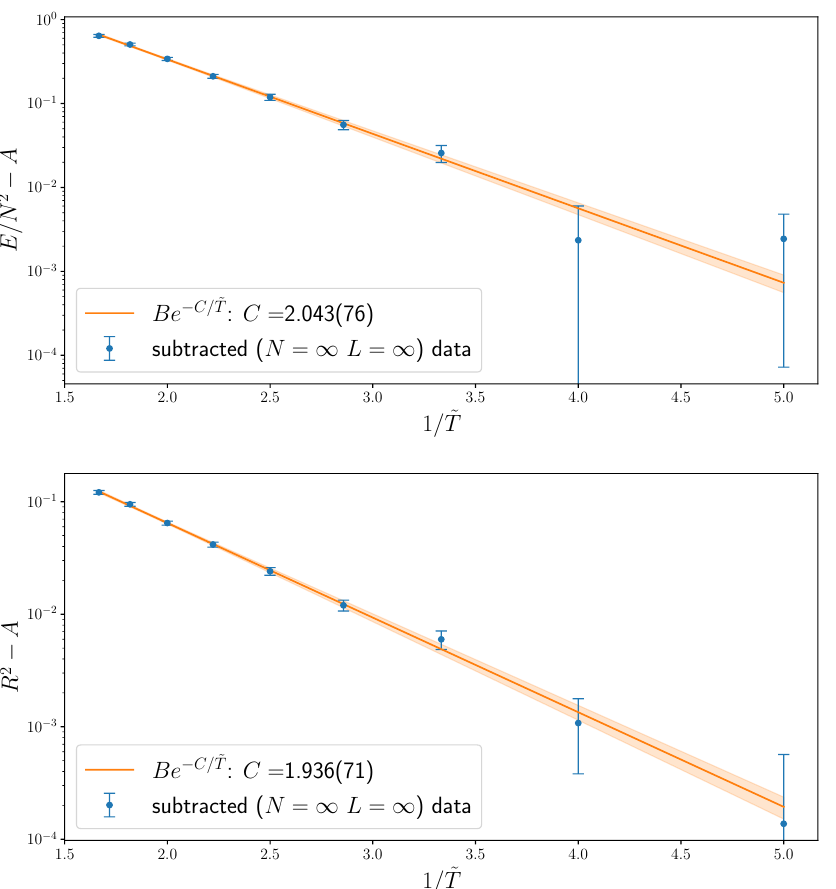
2 = 3 R 2 in the ungauged bosonic matrix model in the Figure 3. ~ E=N 2 (cid:21) ( (cid:21) (cid:0) 1 = 3 E ) =N 2 and ~ R 2 (cid:0) (cid:17) (cid:17) low temperature region, after subtracting the ~ T = 0 (cid:12)tted value A (see text and (cid:12)gure 2), which represents the energy of the gauged theory in the con(cid:12)ning phase. Both di(cid:11)erences behave as a falling exponential Be (cid:0) C= ~ T , where C 2 : 0. The values of A extracted from the (cid:12)t agree with the ’ values obtained in ref. [33] for the gauged